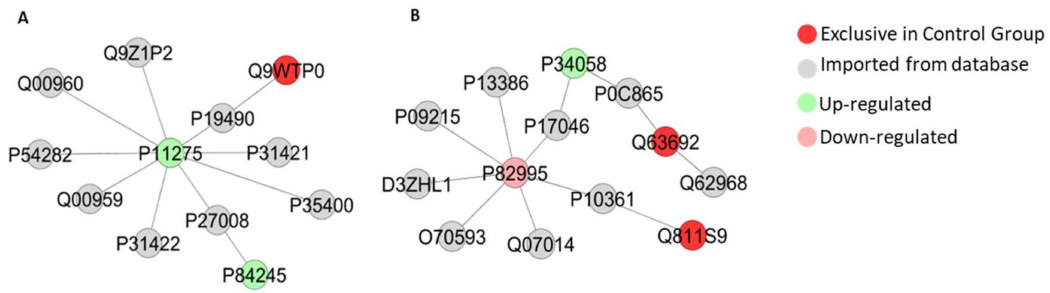
Figure 10. Sub-networks created by ClusterMarker app to determine the interaction among identified proteins of the cerebellum with di ff erent expression on exposed group vs. control group, named by its accession ID from Uniprot. In A: Calcium / calmodulin-dependent protein kinase type II subunit alpha (P11275), Glutamate receptor 1 (P19490), Band 4.1-like protein 1 (Q9WTP0), Metabotropic glutamate receptor 2 (P31421), Metabotropic glutamate receptor 7 (P35400), Poly [ADP-ribose] polymerase 1 (P27008), Histone H3.3 (P84245), Metabotropic glutamate receptor 3 (P31422), Glutamate receptor ionotropic, NMDA 2A (Q00959), Voltage-dependent P / Q-type calcium channel subunit alpha-1A (P54282), Glutamate receptor ionotropic, NMDA 2B (Q00960) and Alpha-actinin-1 (Q9Z1P2). In B: Heat shock protein HSP 90-alpha (P82995), Lysosome-associated membrane glycoprotein 2 (P17046), Heat shock protein HSP 90-beta (P34058), Mitogen-activated protein kinase 7 (P0C865), Hsp90 co-chaperone Cdc37 (Q63692), Sodium channel protein type 10 subunit alpha (Q62968), Cellular tumor antigen p53 (P10361), Guanine nucleotide-binding protein-like 3 (Q811S9), Tyrosine-protein kinase Lyn (Q07014), Small glutamine-rich tetratricopeptide repeat-containing protein alpha (O70593), Kinase suppressor of ras 1 (D3ZHL1), Protein kinase C delta type (P09215) and High a ffi nity immunoglobulin epsilon receptor subunit beta